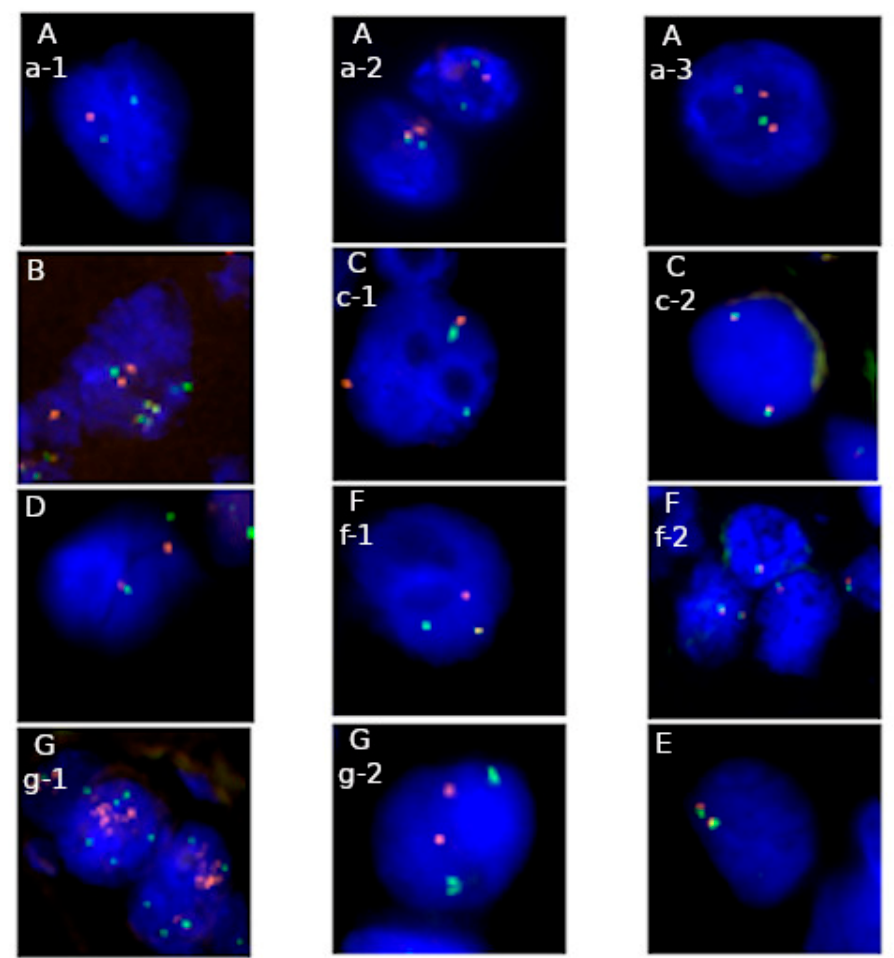
Figure 1. Applications of fluorescence in situ hybridization (FISH) in genetic diagnostics in solid tumors on FFPE material: A —1p / 19q probe: a-1 deletion of 1p32 locus , a-2 normal signal pattern